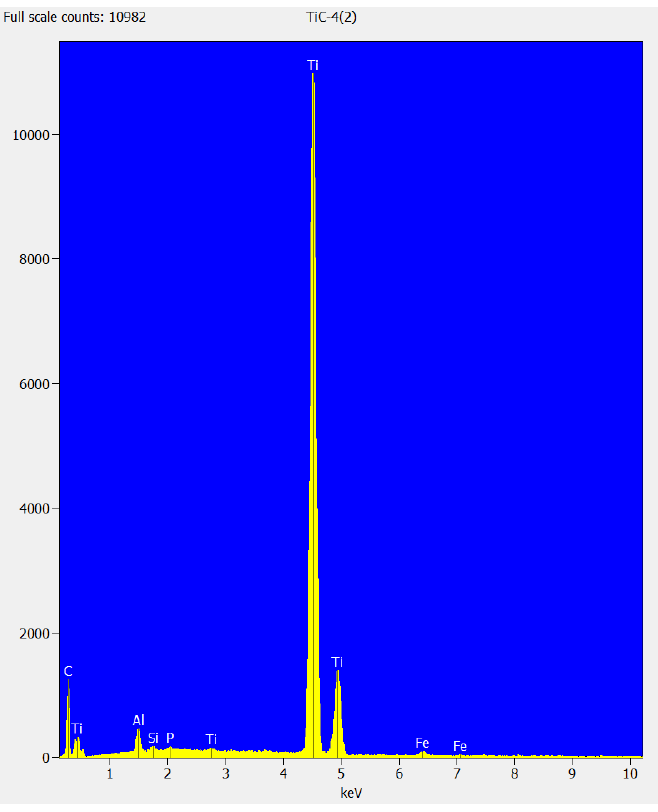
Figure 3. SEM images of the samples: ( a ) TiC-900; ( b ) TiC-1000.